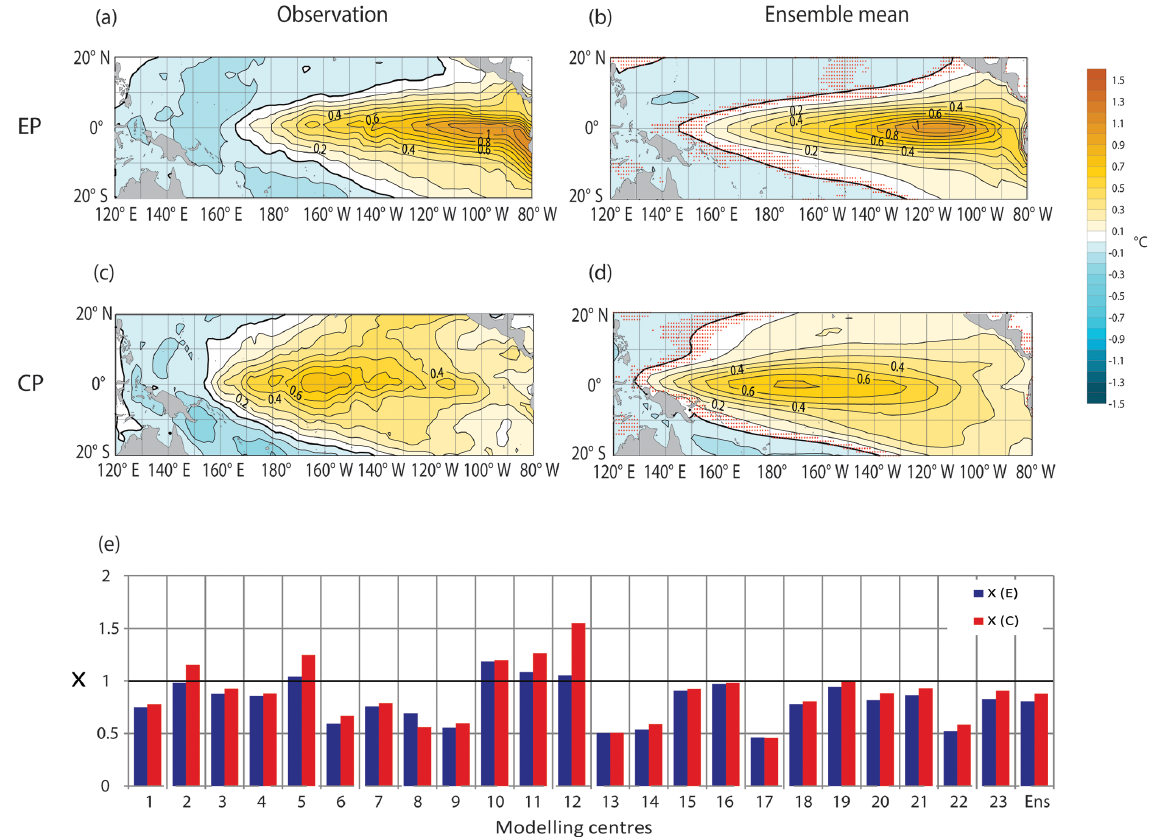
Figure 1. E and C mode patterns (i.e. regression of SST anomalies onto the E and C indices) for (a, c) the observations and (b, d) the ensemble mean of the CMIP5 models (see Table 1 for the model names). The estimate from the models is based on 250 years of the PI control experiment. Stippling (red dots) indicates where the sign of the E and C patterns differs among the models by 70%. (e) Histogram RR x = 80 ◦ W ,y = 10 ◦ N (Y obs (x,y) · Y model (x,y)) d x d y x = 120 ◦ E ,y = 10 ◦ S of the quantity X is defined as X = for the different models and the ensemble mean and where Y RR x = 80 ◦ W ,y = 10 ◦ N (Y obs (x,y) · Y obs (x,y)) d x d y x = 120 ◦ E ,y = 10 ◦ S is either E or C . X is thus a metric of the model skill in accounting for the spatial pattern and amplitude of the E and C modes. Blue (red) refers to the E (C)